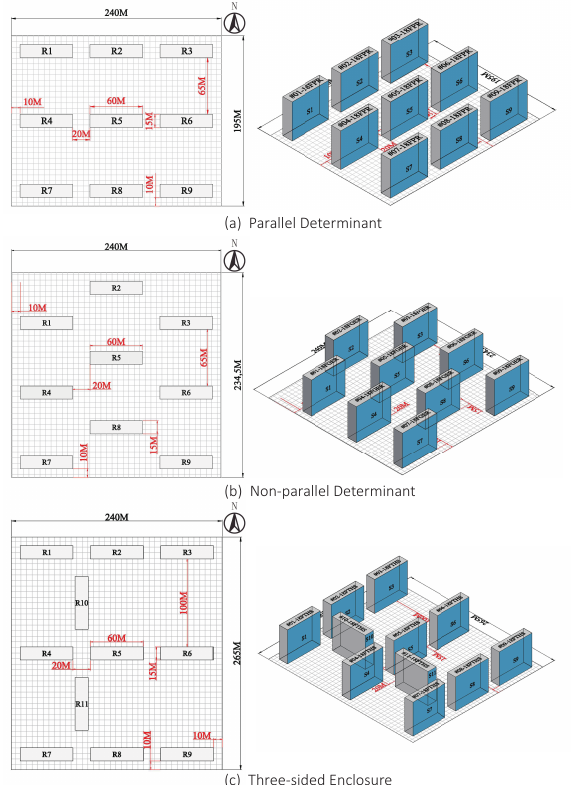
Figure 2. Three typical residential layout patterns (take 18 Floor as an